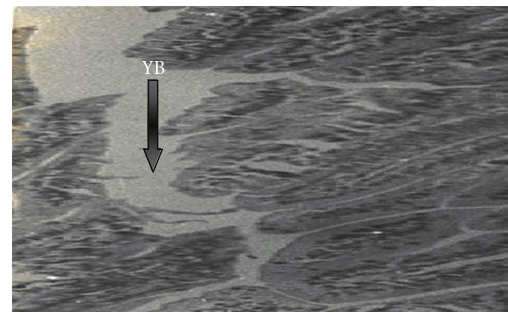
Figure 12: Plate of photomicrograph of intestine of Clarias gariepinus after 12 weeks exposure to 25ppb of gammalin 20 showed yellow bodies (YB) at the lamina propria of the mucosal